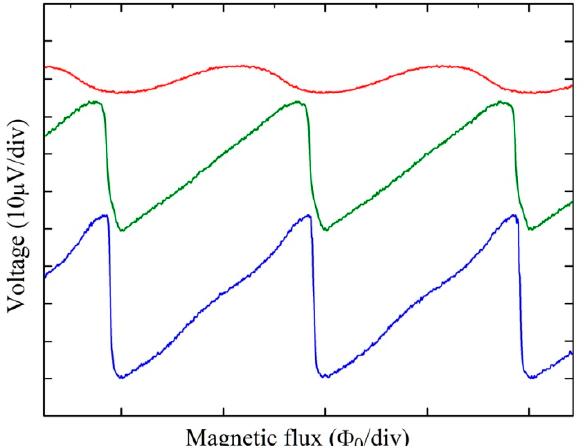
Figure 3. SQUID voltage as a function of the external magnetic flux measured at T = 4.2 K (lower curve). The medium (green) and the top (red) traces refer to the same magnetometer for an annealing temperature of 200 and 240 °C, respectively.